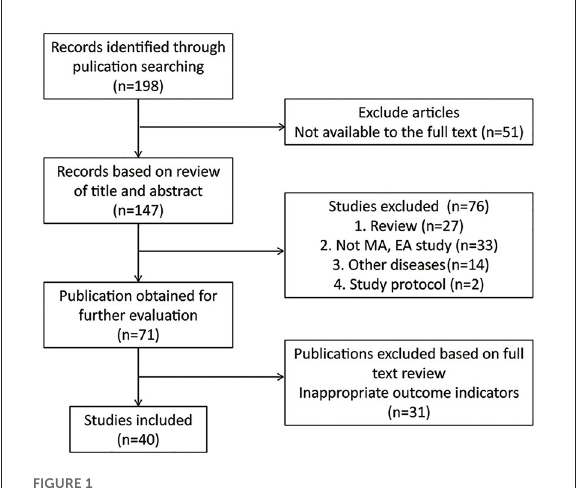
FIGURE1 Flow chart of study selection. MA, manual acupuncture; EA,